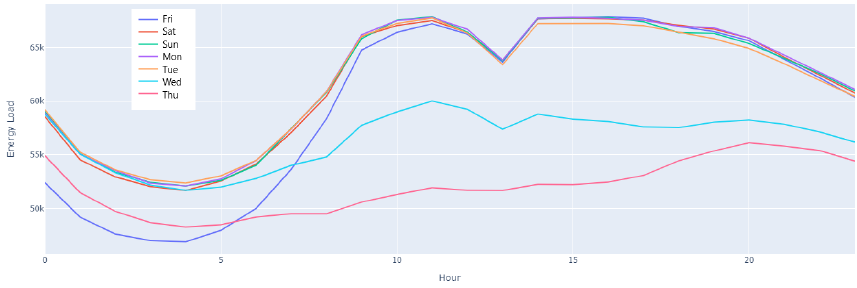
Figure 9. Median hourly power demand per